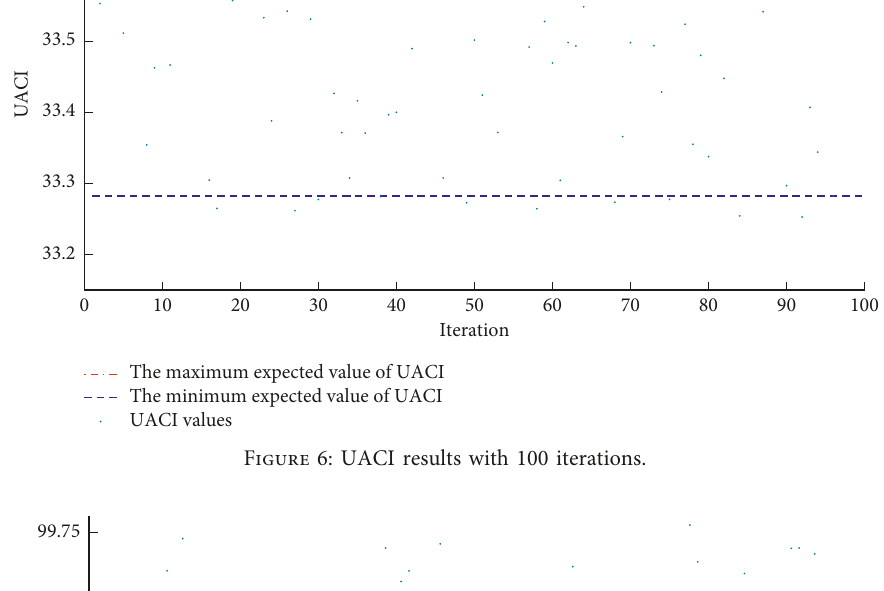
Figure 6: UACI results with 100 iterations.